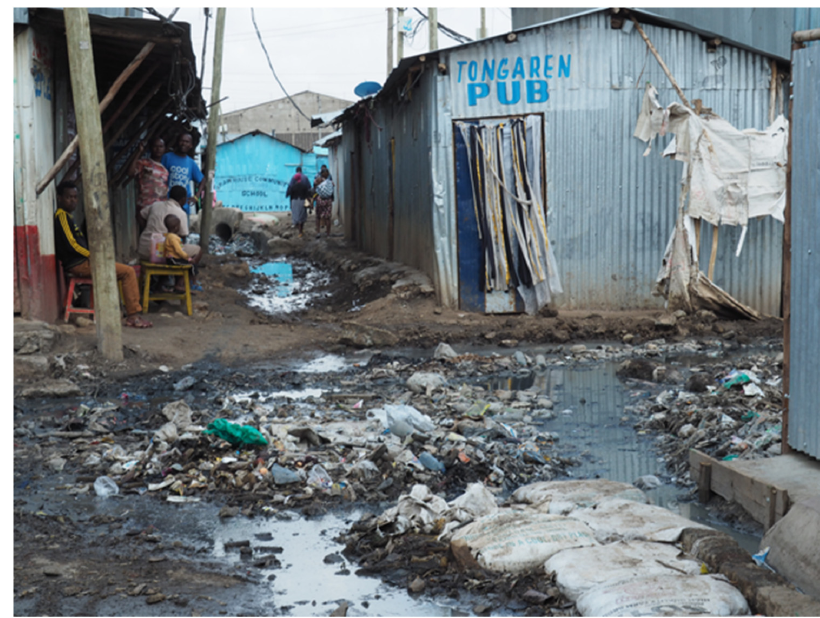
Figure 4. Flooded Street in Mukuru, Nairobi.